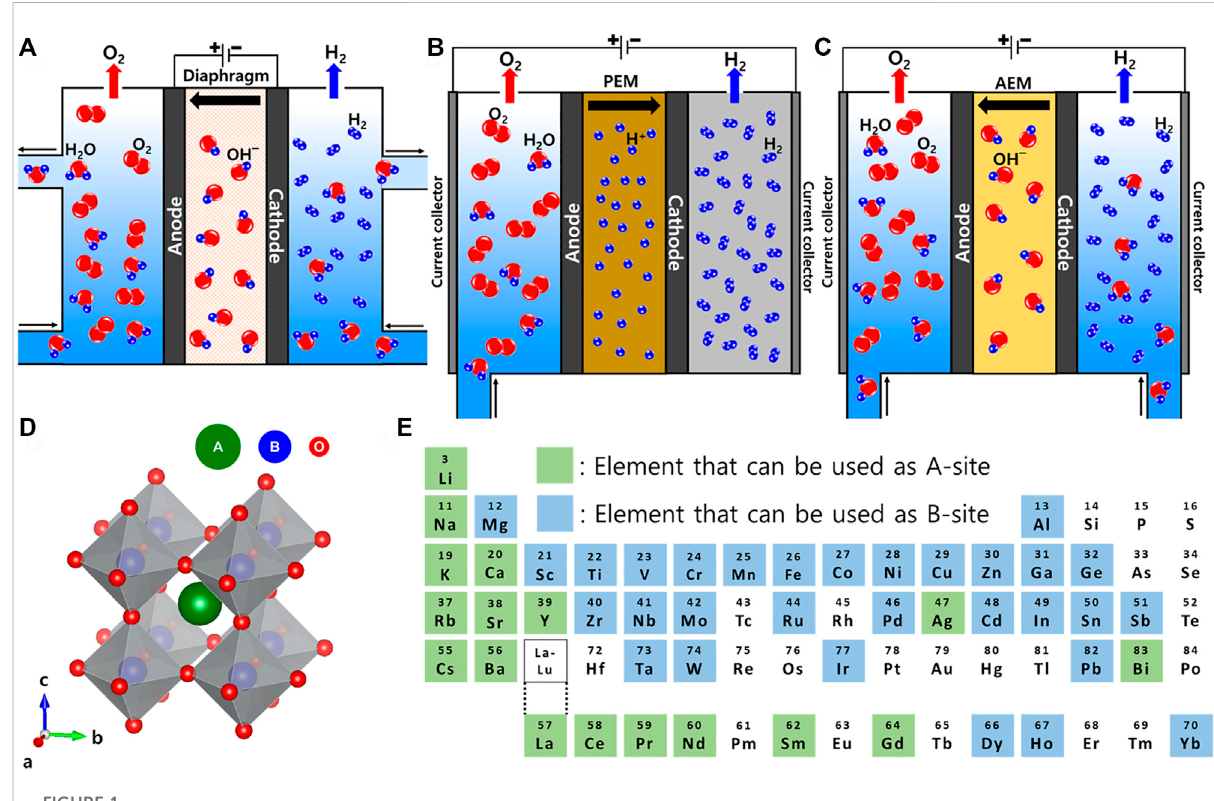
FIGURE 1 Schematic illustration of (A) AWE, (B) AEMWE, and (C) PEMWE systems. (D) Scheme of typical ABO 3 perovskite structure. (E) A map of the elements in the periodic table that can be used for A- and B-sites of the ABO 3 perovskite